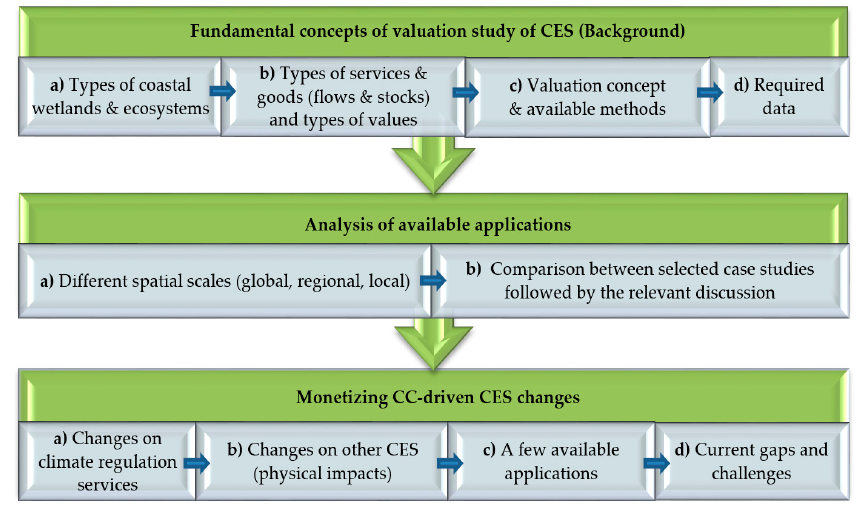
Figure 1. Schematic depiction of the sequential structure of this article.